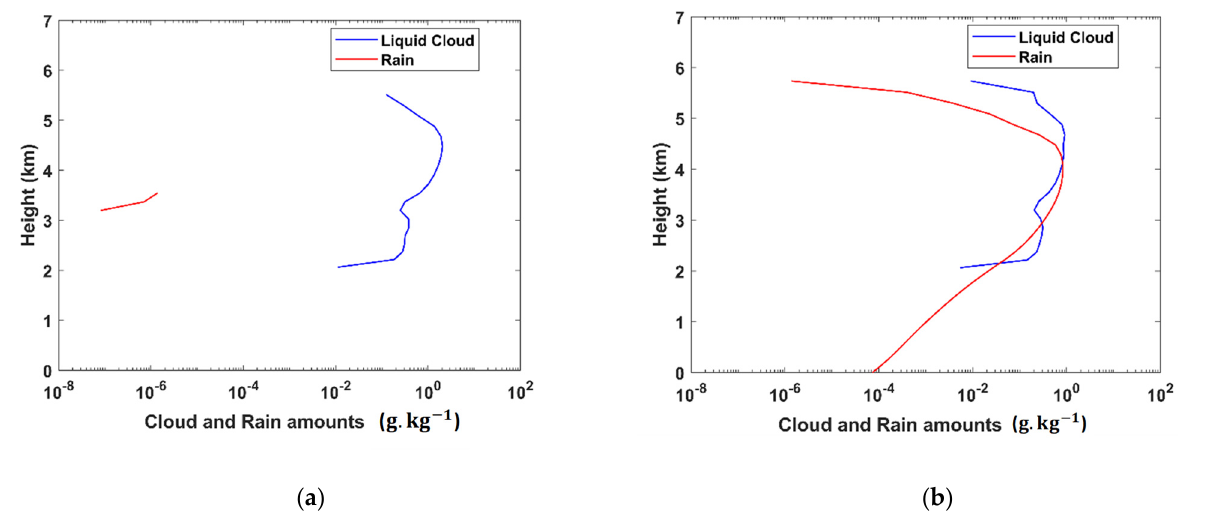
Figure 5. Vertical profiles of cloud and rain mixing ratios at ( a ) the model time of ~10.7 h (1608 IST) and ( b ) 22 min past the initial time.